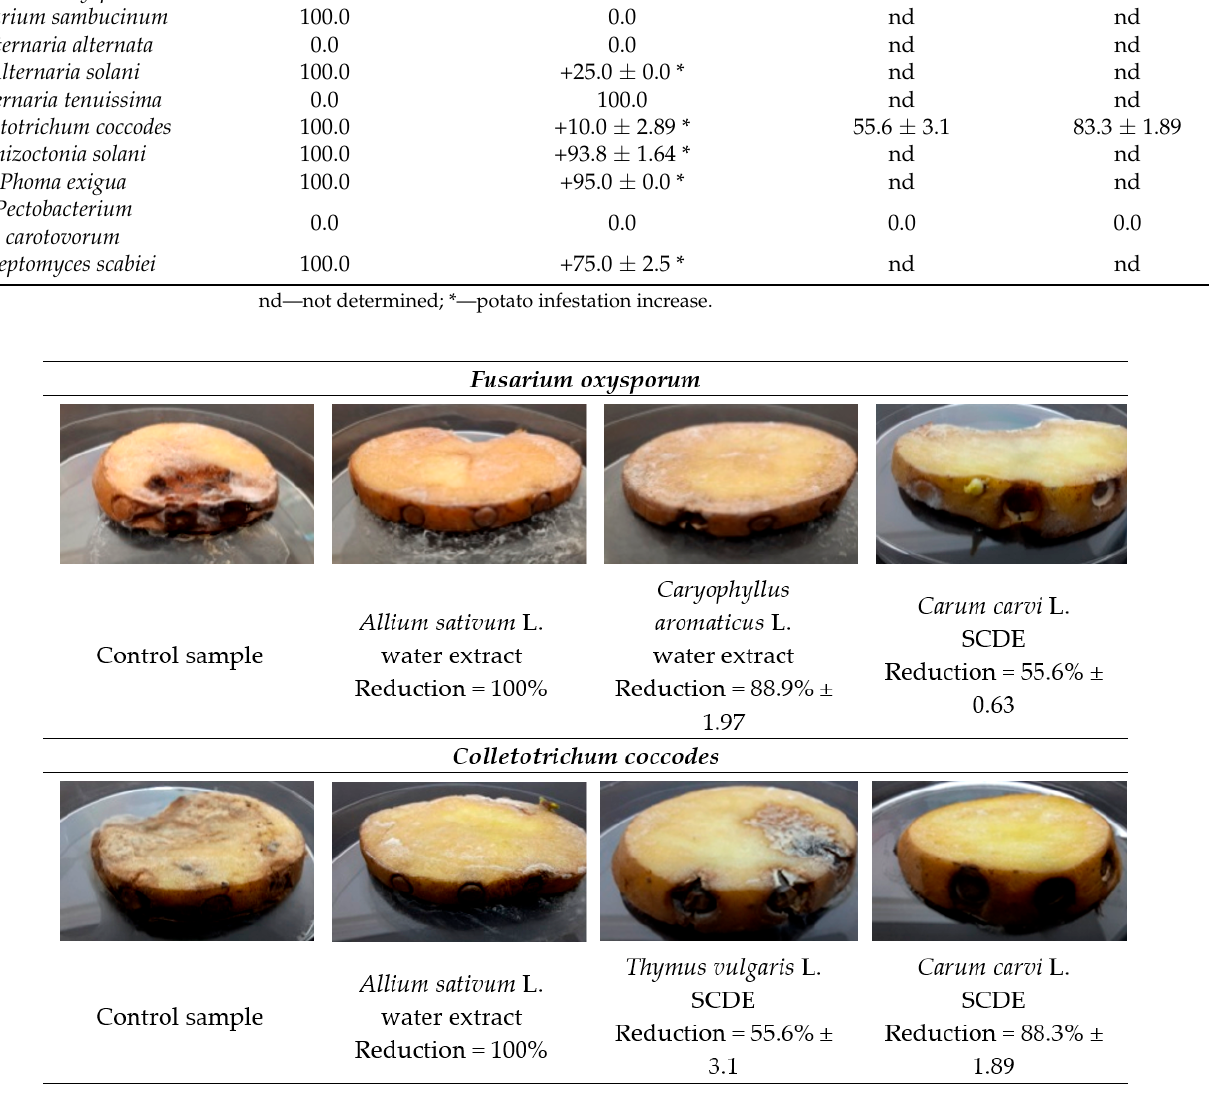
Figure 4. Inhibition of F. oxysporum and C. coccodes infestation of potatoes cv. Impresja treated with plant extracts.